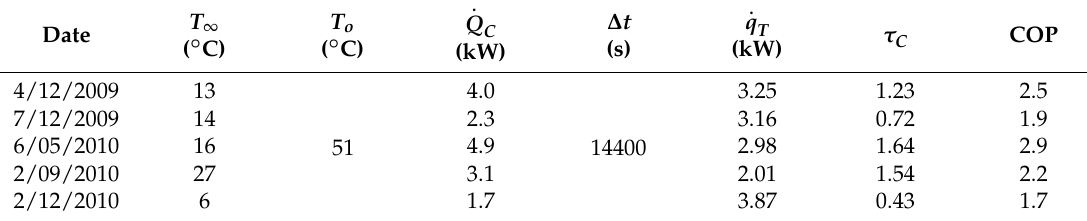
Table 5. Thermal capacity for the experimental setup by Moreno-Rodriguez